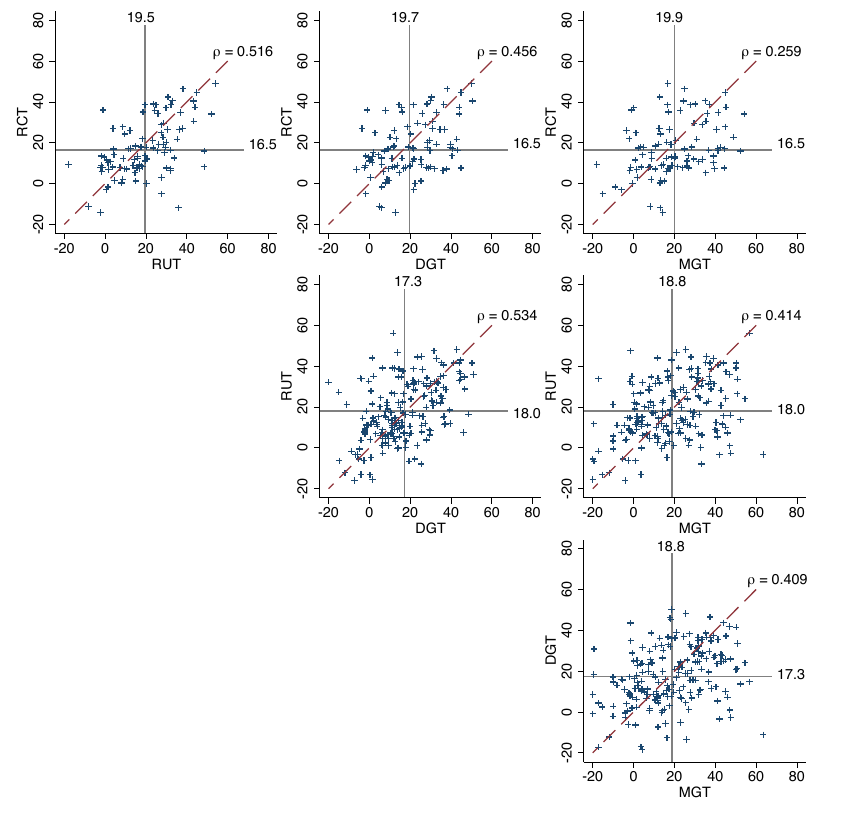
Figure 4. SVO scatterplots and Spearman’s rank correlations ( ρ ). Horizontal and vertical lines represent mean values of the corresponding treatment. When RCT is involved, indicated mean values differ from the mean values in Table 1. This is because the data used for the production of this figure is based on mean values that are computed over all subjects who made incentivized choices in both treatments, the treatment on the x -axis and the treatment on the y